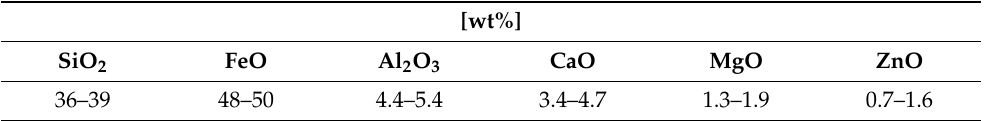
Table 1. Main components of the settling furnace